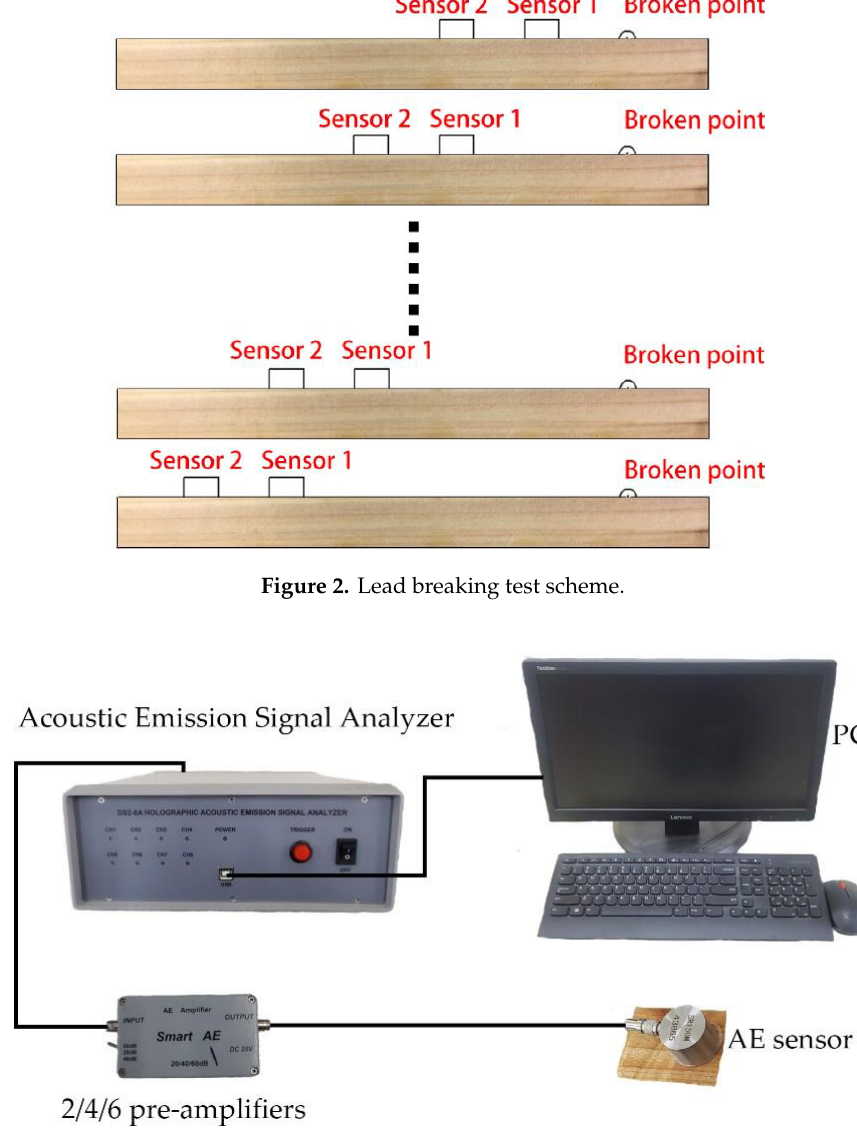
Figure 3. A diagram to show the instrument connection for the acoustic emission.